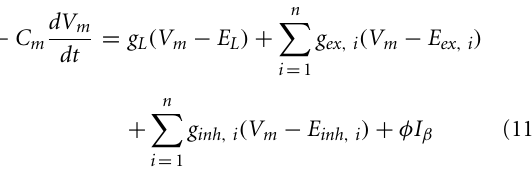
propagated to the mutual eligibility trace E ij . (B) A reward (pink rectangular function, not to scale) is delivered as external supervision. Resulting E traces are indicated (gray line, τ e = 100ms and black line, τ e = 1000ms). (C) Behavior of color corresponding P ij traces and weights (inset) depends on whether or not the reward reached the synapses in ample